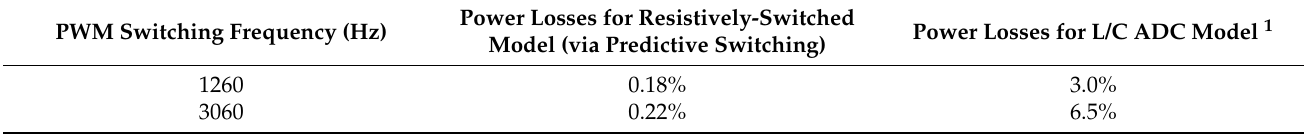
Table 1. Power losses for resistively-switched (Substep environment) vs. L/C associated discrete circuit (ADC) models of an NPC